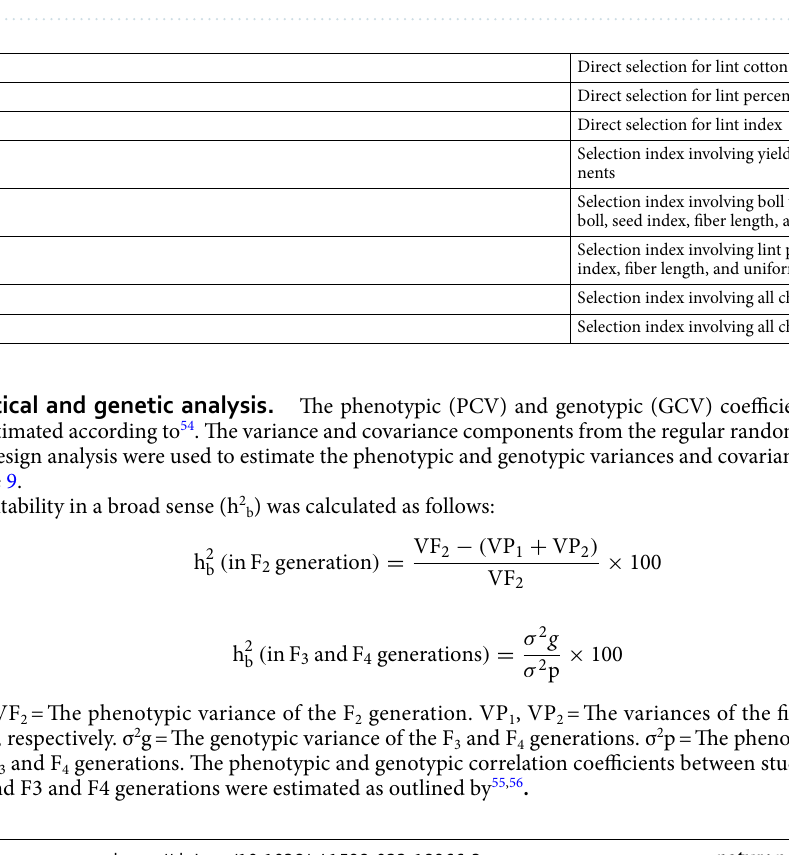
Figure 5. Path diagram of the direct and indirect effects of the studied traits in